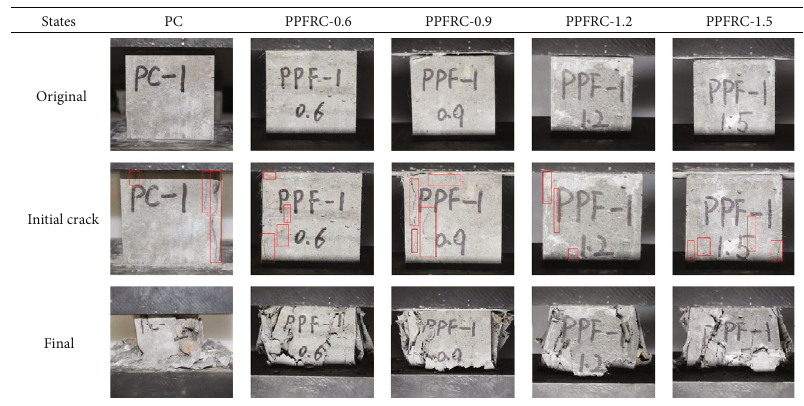
Figure 5: Macroscopic pictures of the initial crack, original, and fi nal states of PC and PPFRC at 28 days of curing.